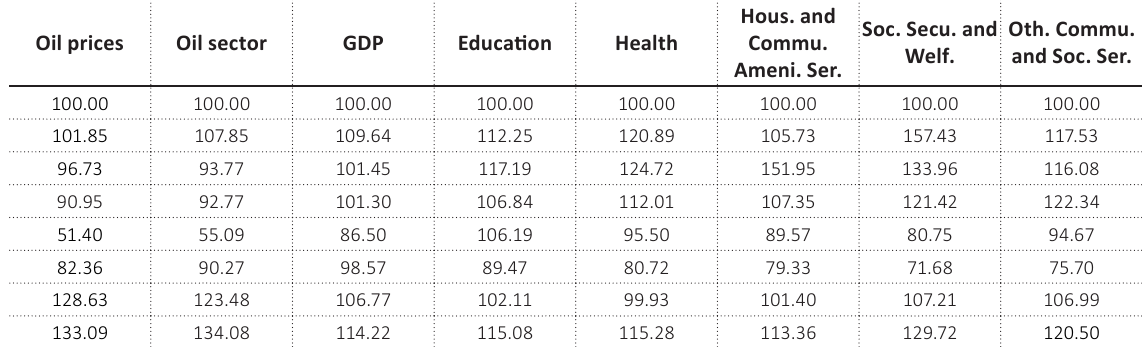
Source: Own calculations based on absolute values given in Table 1.